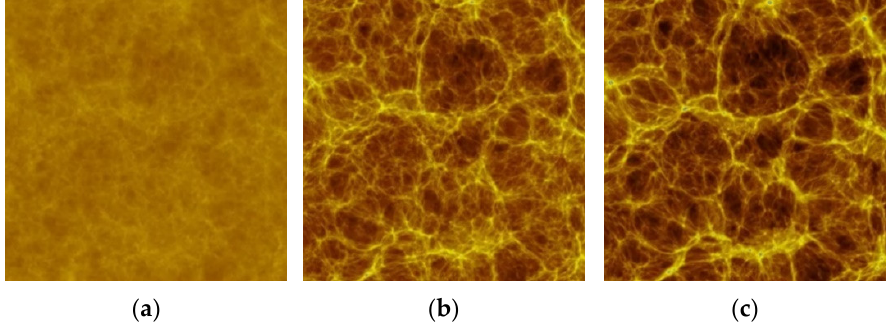
Figure 11. Benchmark of image analysis, the evolution of the universe [68]: ( a ) 500 million years after Big Bang image with faint clustering, average brightness 0.45; ( b ) 5000 million years after Big Bang image with clustering, average brightness 0.37; ( c ) 10,000 million years after Big Bang image with intense clustering, average brightness 0.33. Source: [39].